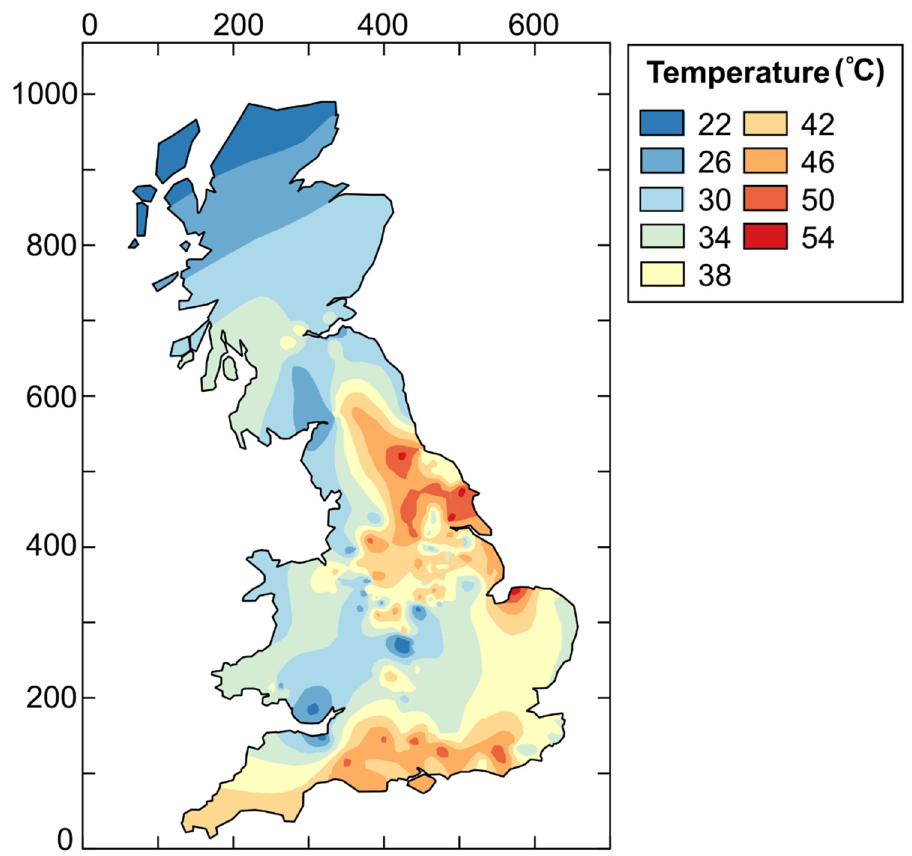
Figure 4. Regional temperature variation at 1 km depth across the UK, modified after [51]. British National Grid co-ordinates (north and east) are in 100 km intervals.